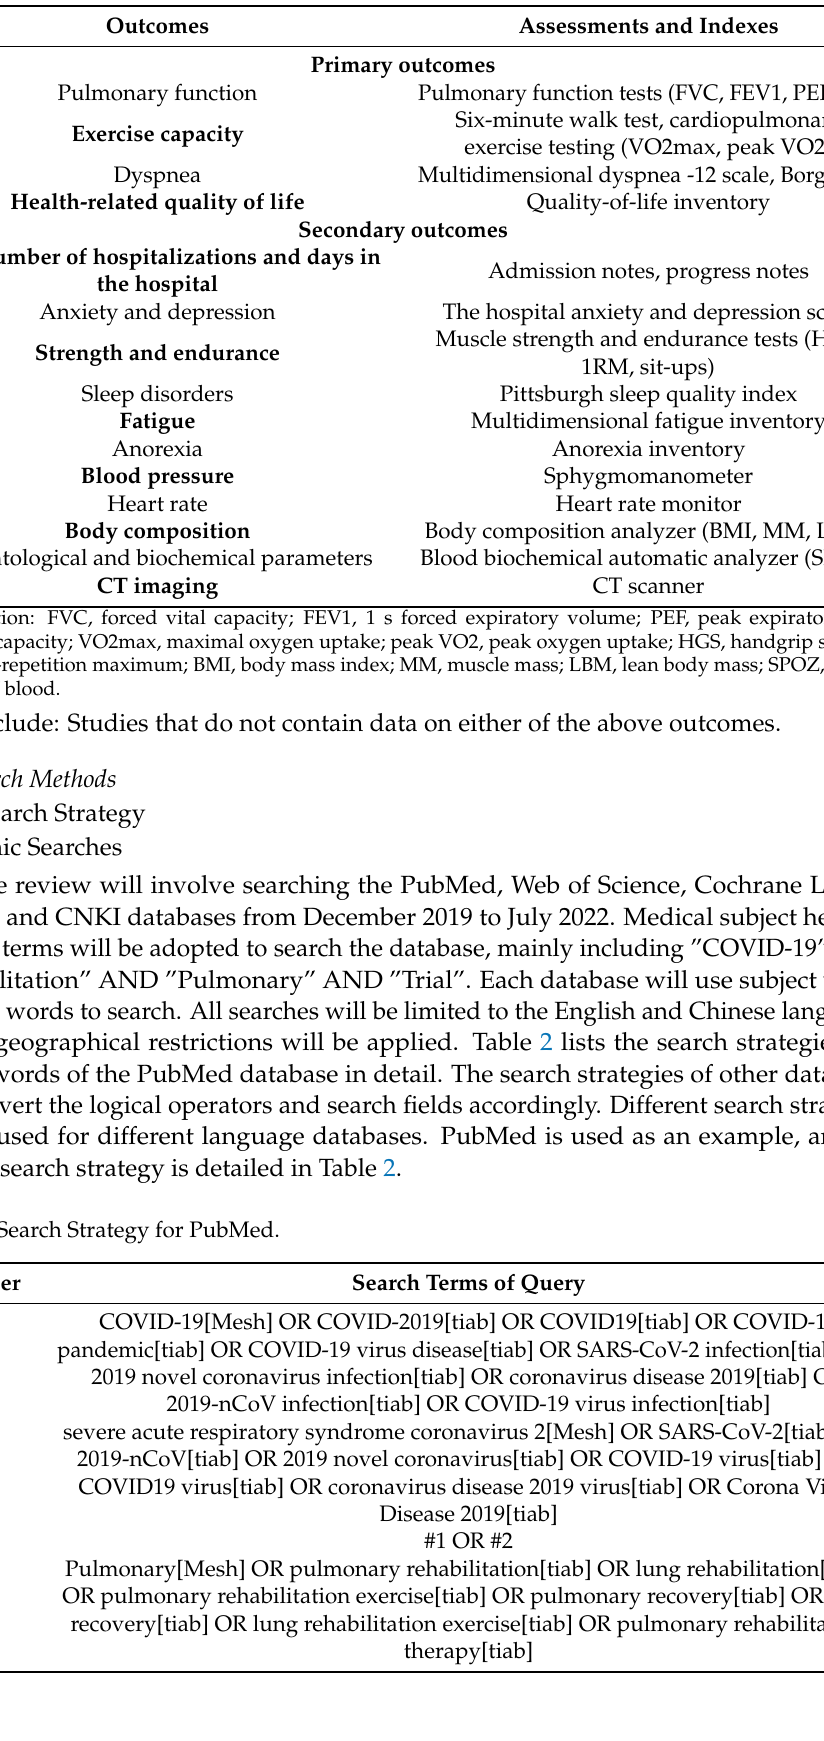
Table 1. Outcomes and Measurements Will be Included in the Review.